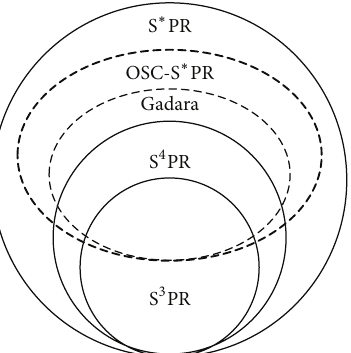
Figure 8: Modeling capabilities of some subclasses of S ∗ PR